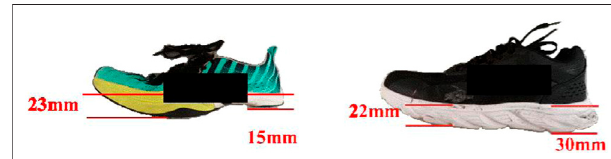
FIGURE 1 | Illustration of shoe types (left side: running shoes with the − 8 mm HTD; right side: running shoes with the 8 mm HTD).